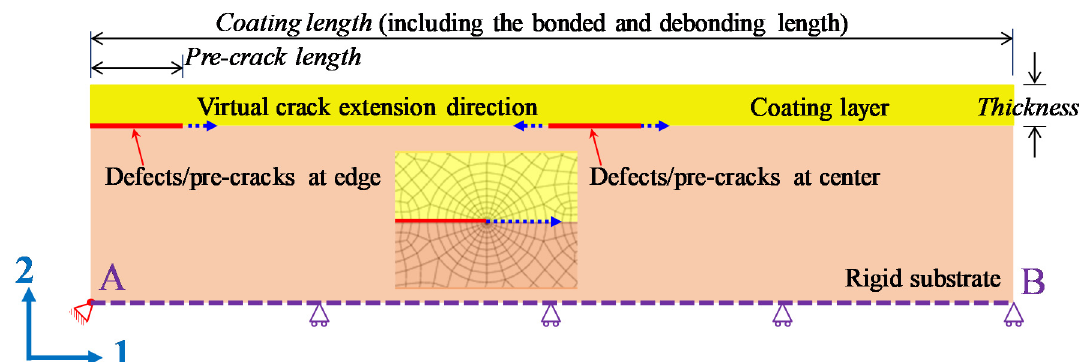
Figure 1. Schematic of a plane-strain finite element (FE) model. (Inset shows the FE mesh around the crack tip).